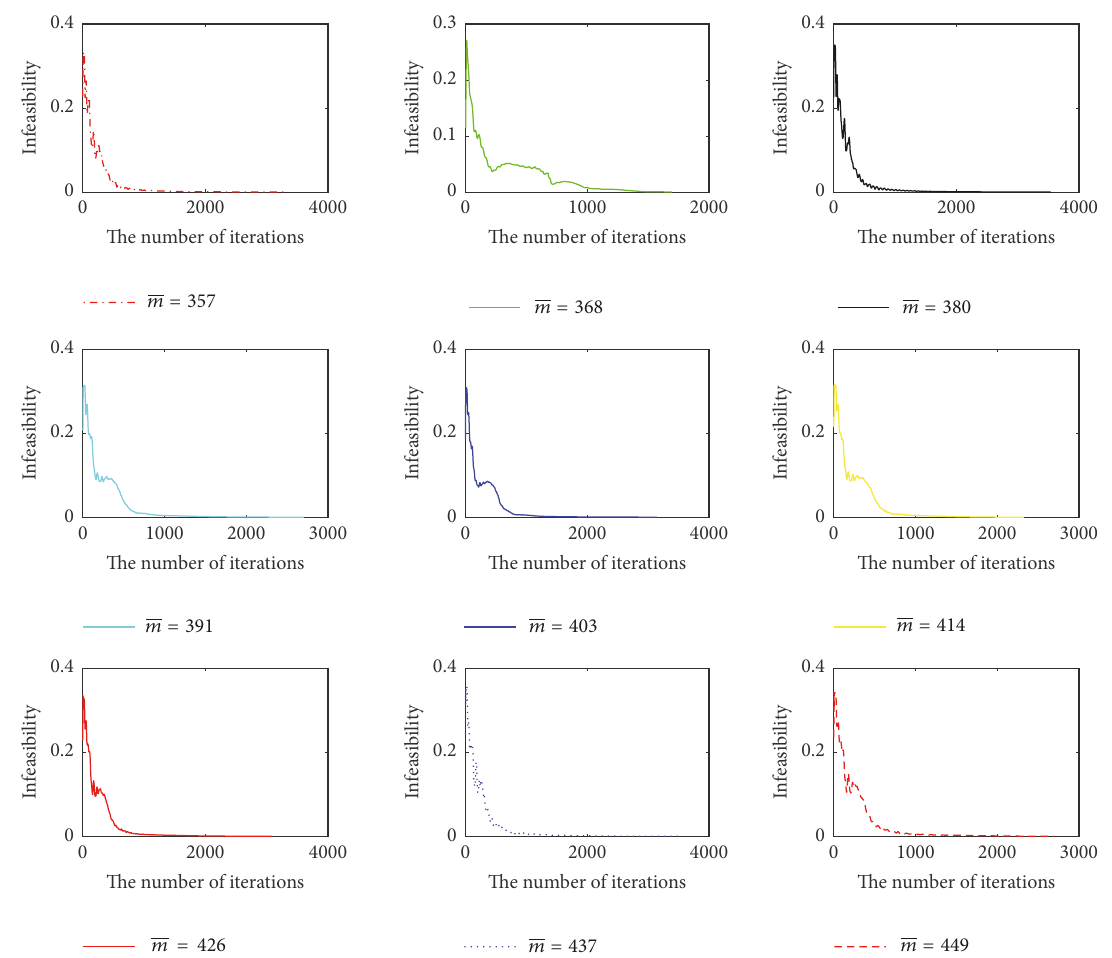
Figure 7: The numerical convergence behavior of TSADMM with different choices of 𝑚